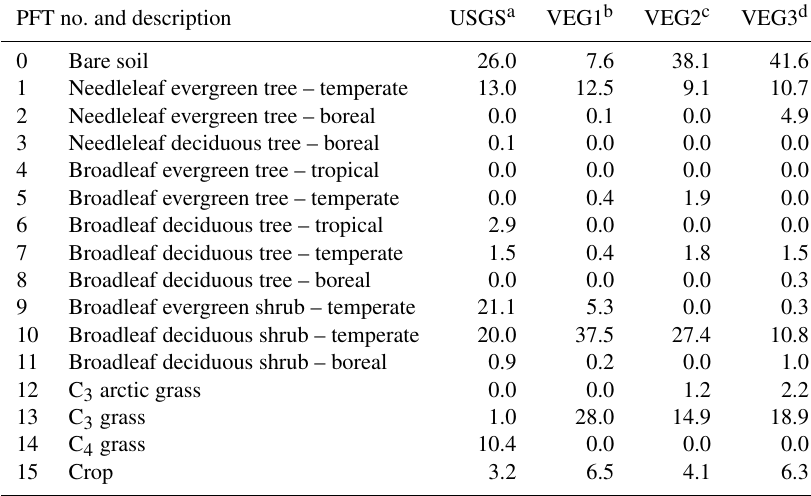
Table 1. Average percentage of PFTs over the simulation domain. PFT no. and description USGS a